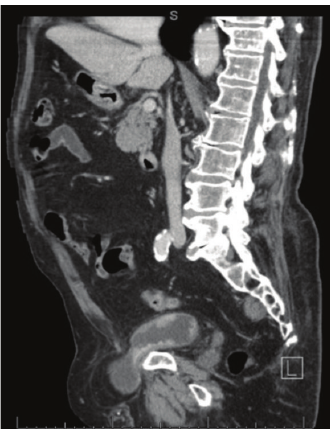
Figure 1: Sagittal view of herniated bladder with transitional cell carcinoma.